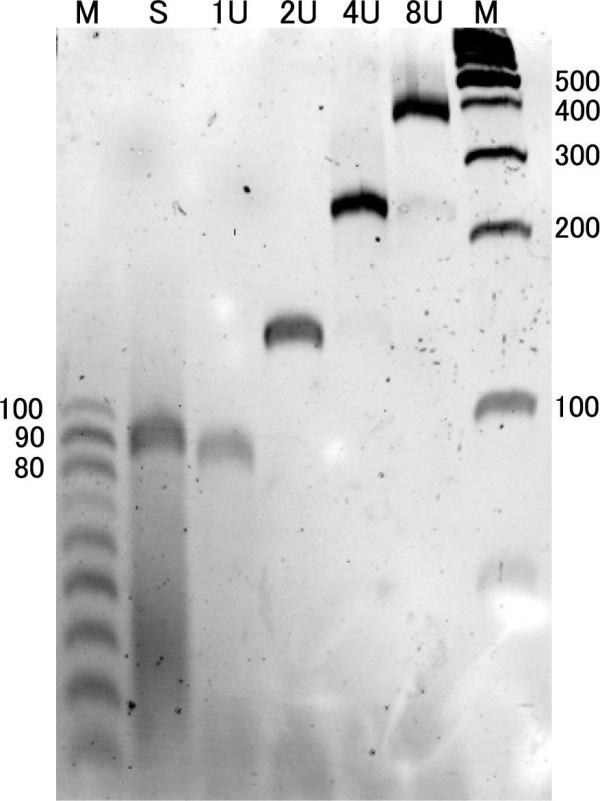
Production of 2×, 4×, and 8× length library. Lane-M: Size marker. 10 base ladder (left) and 100 base ladder (right). Lane-S: Initial synthesized library (87 mer). Lane-1U: Initial single-unit library (94 mer) made by PCR amplification. Lane-2U: Double-unit library (138 mer) made by ligation product of digested 1U. Lane-4U: quadruple-unit library (240 mer) Lane-8U: octuple-unit library (444 mer). PAGE was done with 5 % polyacrylamide, TAE buffer (pH 8.0), 8 M urea, 65°C and stained with SybrGreen I and visualized with a fluorescence imager (Bio-Rad FX).